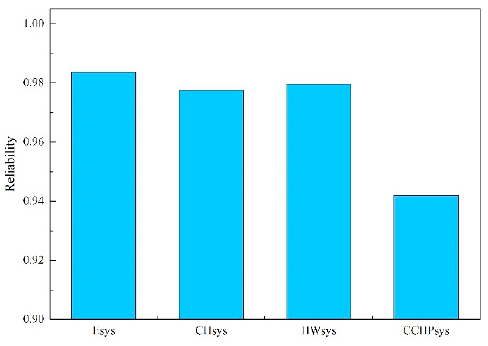
Figure 10. The reliability of the systems of the CCHP system at KSRP.